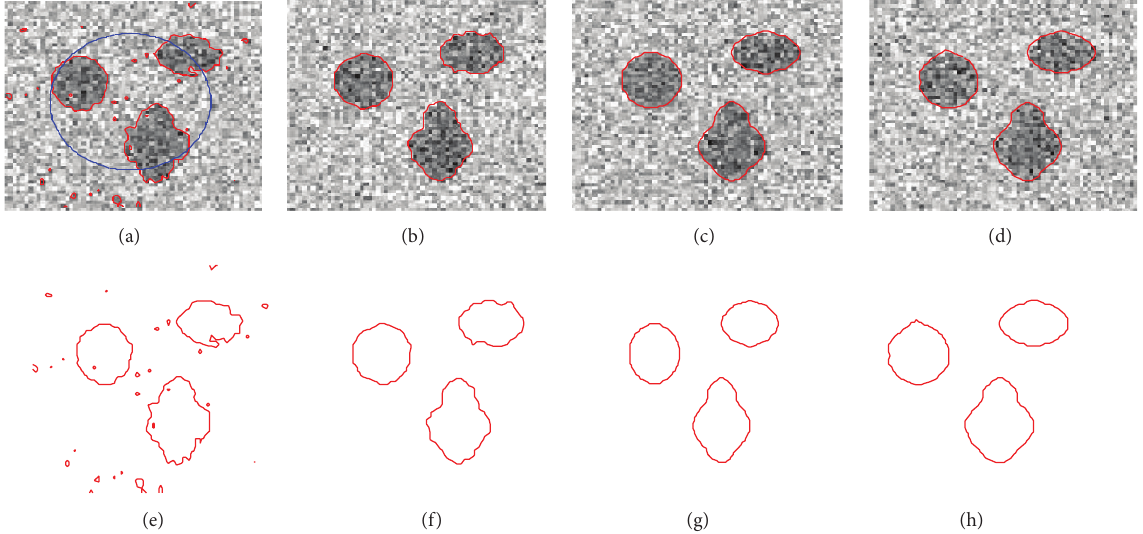
Figure 2: Segmental results of a noisy image with Gaussian variance 0.1. (a) Segmental result with CV model and the blue curve is the initial contour ( 𝜇 0 = 0.03∗255∗255 ). (b) Segmental result with TV-based segmentation model. (c) Segmental result with adaptive TV-based model. (d) Anisotropic diffusion-based segmentation model. (e), (f), (g), and (h) are the corresponding contours to (a), (b), (c), and (d),